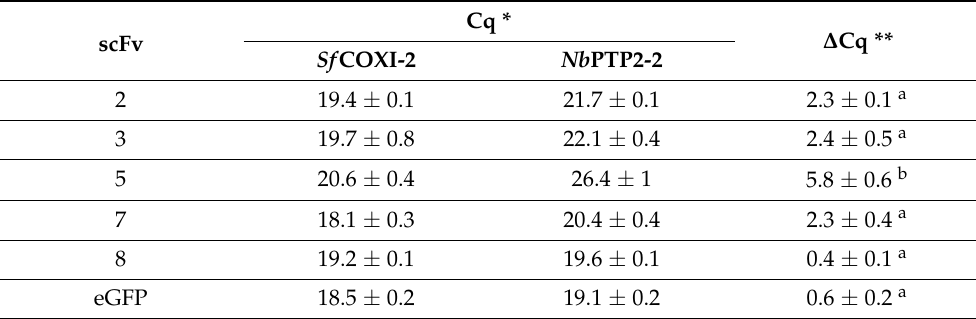
Table 4. Real-time qPCR analysis of N. bombycis PTP2 and S. frugiperda COXI transcripts with primers Sf COXI-2 and Nb PTP2-2 in Sf9 cultures expressing five Nb AAC1-specific recombinant Abs and